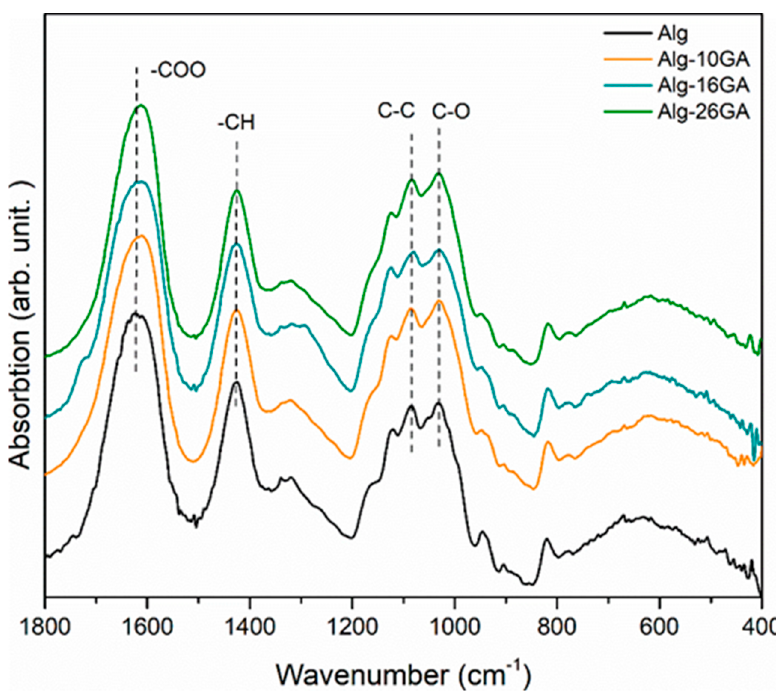
Figure 4. FT-IR spectra of cross-linked Alg-xGA (x = 0, 10, 16, and 26 wt.%) composites.